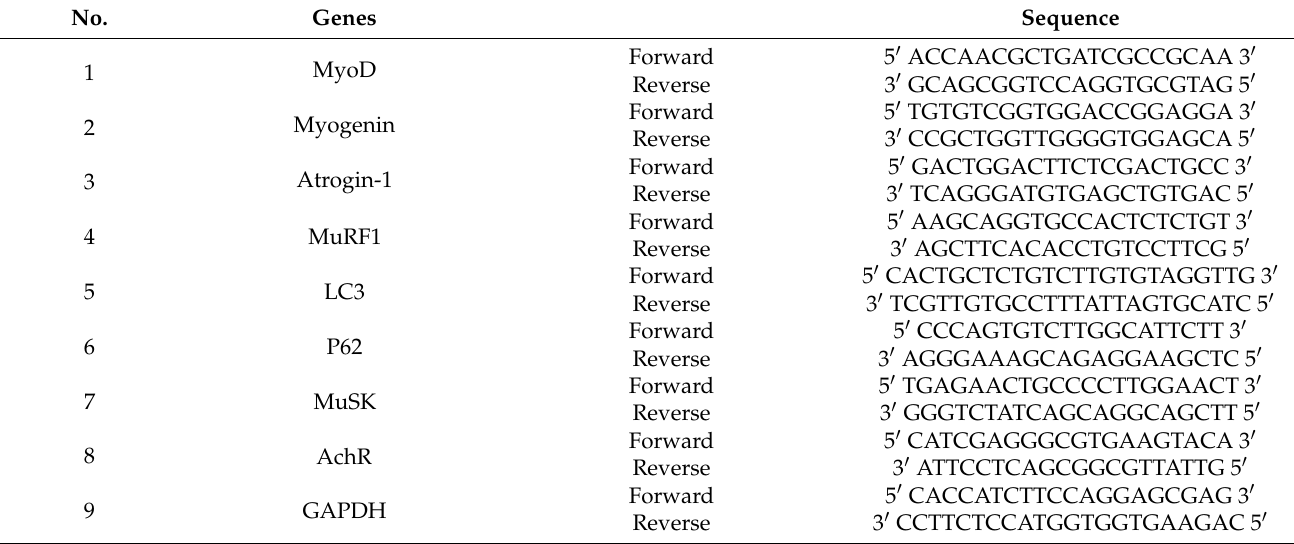
Table 2. The list of primers